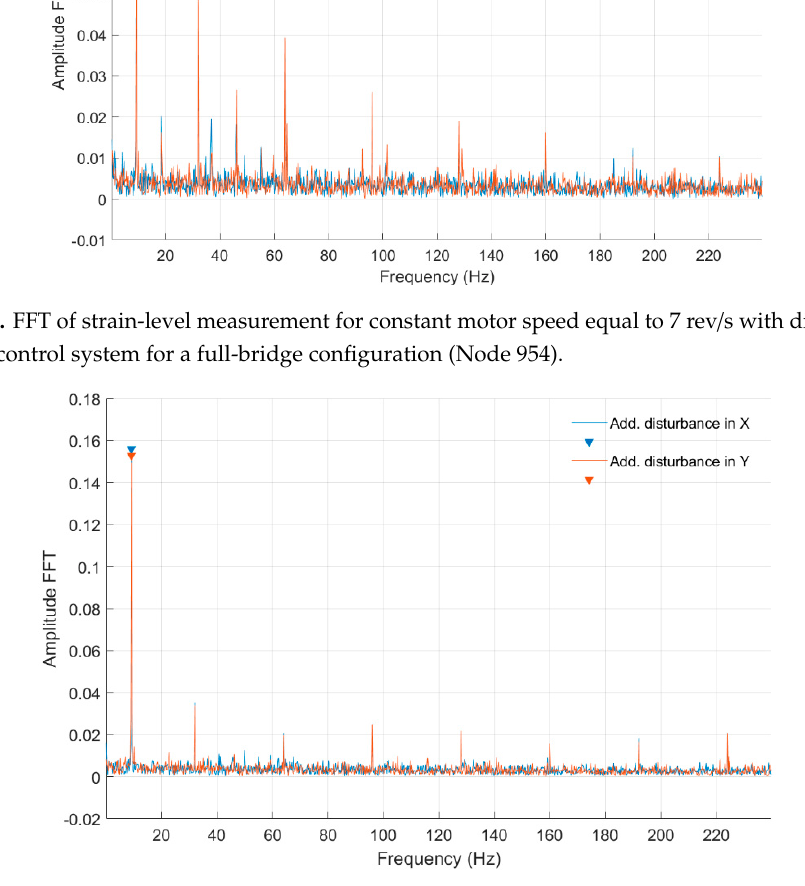
Figure 17. FFT of strain-level measurement for constant motor speed equal to 7 rev/s with disturbance from the control system for a full-bridge configuration (Node 955).